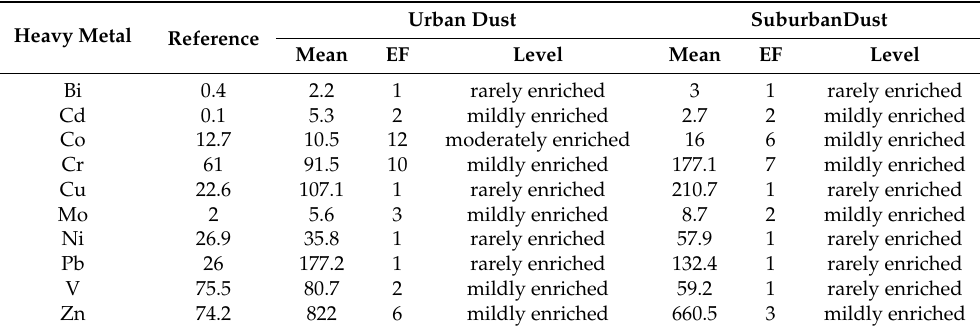
Table 4. The enrichment factor of dust heavy metals during winter in Beijing.